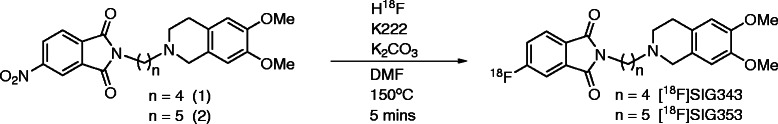
Radiosynthesis of 
18
F-SIG343 and 
18
F-SIG353.